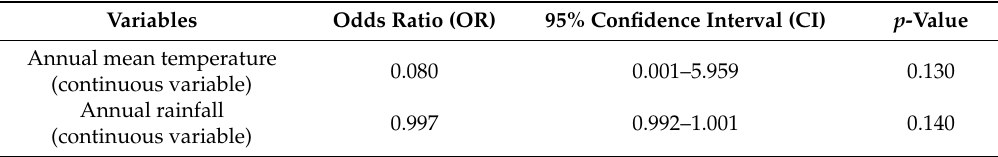
Table 1. Possible risk factors associated with higher Toxoplasma gondii prevalence in sheep farms using univariate analysis.